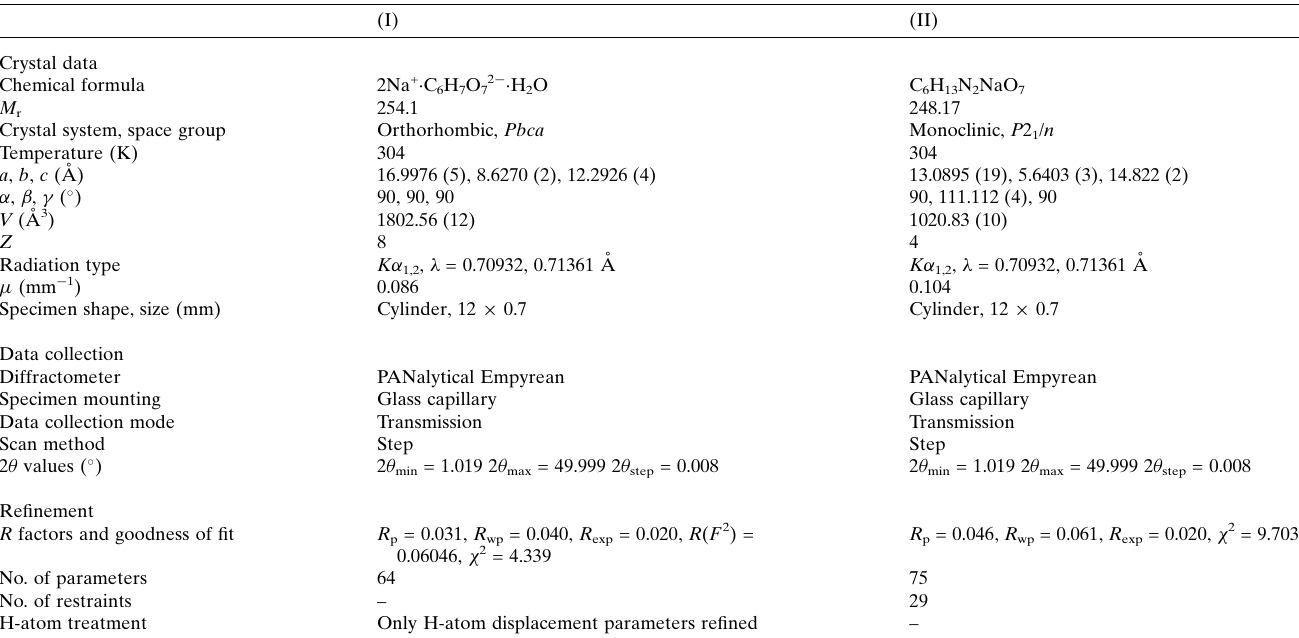
Table 3 Experimental details.